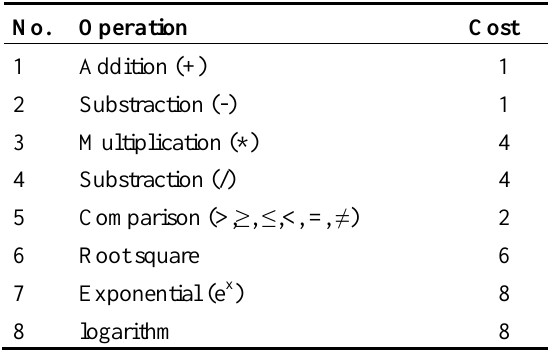
Table 6 . The cost values for basic operations mostly used to evaluate the computational effort of methods of feature computation.